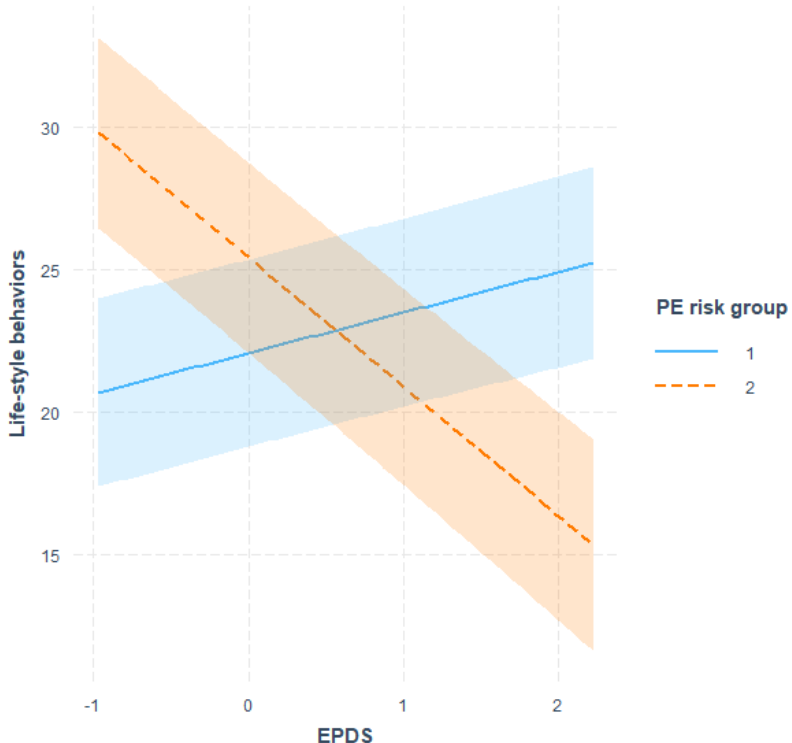
Figure 1. Simple slope analysis for Risk group x Depression interaction at time 3 on Life-Style Be- haviours. Note: PE = preeclampsia; PE risk group 1 = low risk of preeclampsia/PE risk group 2 = high risk of preeclampsia.